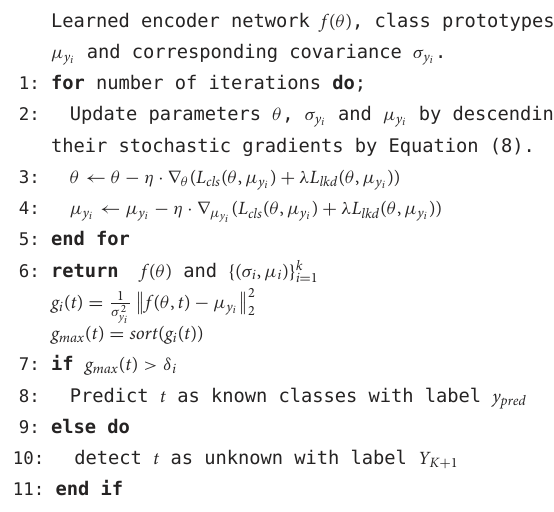
Algorithm 1. The program flowchart of the proposed